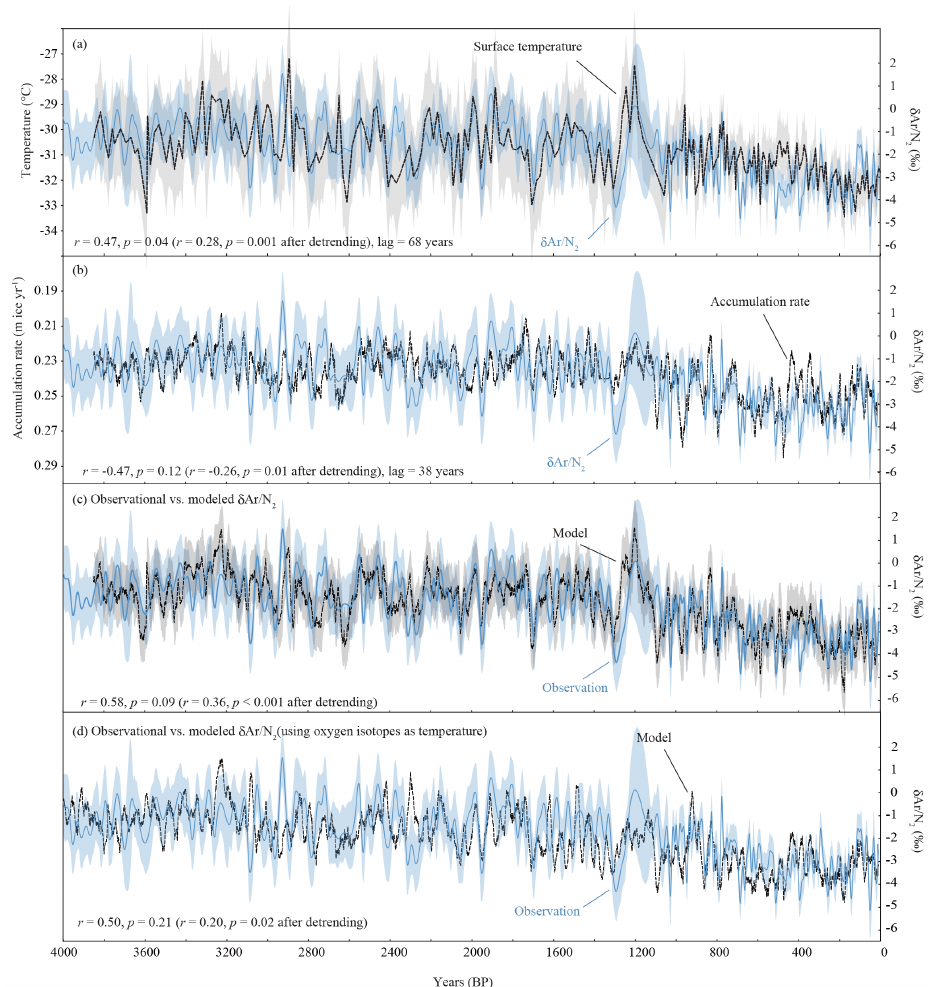
Figure 5. Observed and modeled δ Ar / N 2 , surface temperatures, and accumulation rates from the GISP2 ice core over the past 4000 years. Note that the observed δ Ar / N 2 is corrected for the post-coring fractionation (1.5‰ added). (a) δ Ar / N 2 and surface temperatures (Kobashi et al., 2011). Ages of the temperatures were adjusted for the lag (68 years). (b) δ Ar / N 2 and accumulation rates in 21-year RMs (Alley et al., 1997; Cuffey and Clow, 1997). Ages of the accumulation rates were adjusted for the lag (38 years) (c) Observed and modeled δ Ar / N 2 from multiple linear regression (see text). (d) Observed and modeled δ Ar / N 2 of multiple linear regression using δ 18 O ice as a temperature proxy (see